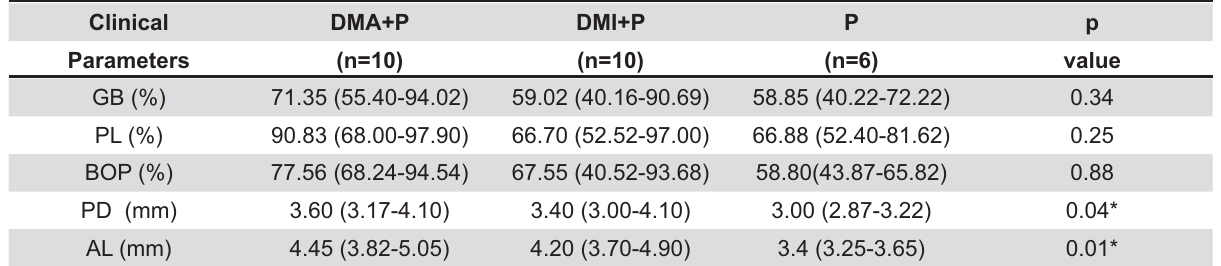
Table 2- Medians and quartiles (25–75%) of clinical parameters for the DMA+P, DMI+P and P